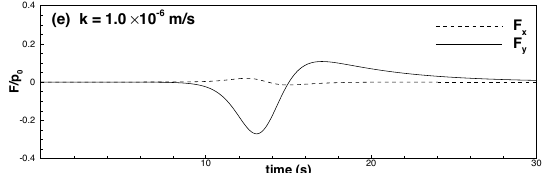
Figure 14. Time evolution of seepage force exerted on the pipeline at E = 1.0 × 10 7 kPa and various k values. ( a ) Dynamic pressure at the seabed above the pipeline; ( b – e ) horizontal and vertical components of seepage force.